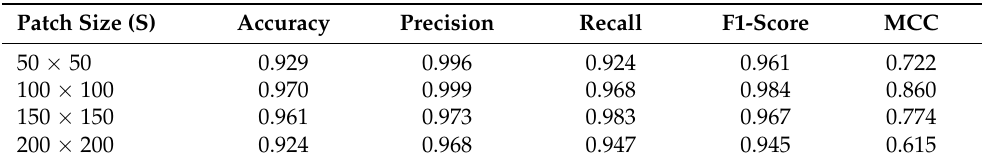
Table 3. Classification results for varying patch size parameter. (focusing parameter γ = 2, weighting factor α = 0.50, 3D convolutions, see Figure A1 for network